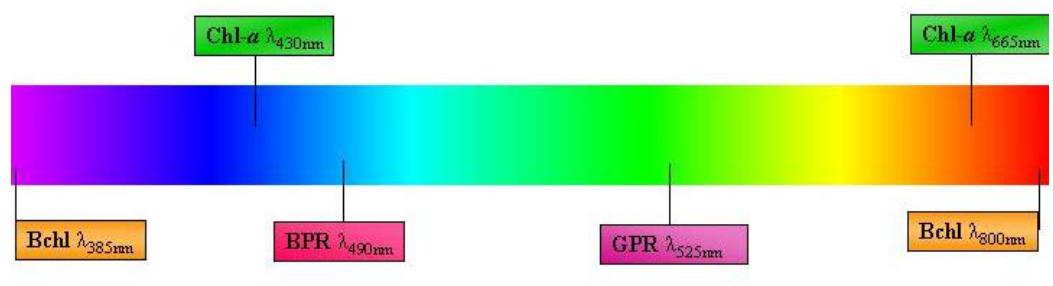
Figure 3. Schematic diagram of light pigments/proteins of sea ice phototrophic bacteria. Bchl = bacteriochlorophyll; Chl- a = Chlorophyll- a ; BPR = Blue proteorhodopsin; GPR = Green proteorhodopsin. Diagram not drawn to